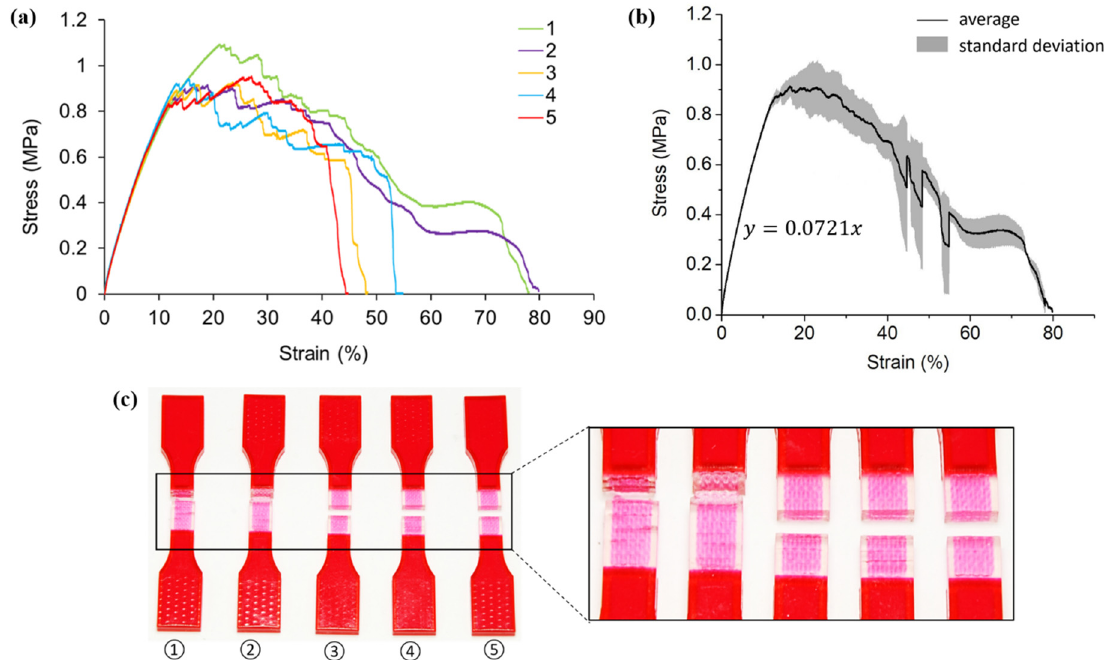
Figure 7. ( a ) Stress-strain curves obtained from tensile testing tests on hybrid case three (pure horizontal second order) samples; ( b ) average tensile stress-strain curve and standard deviation of all five testings; ( c ) pictures of failed tensile samples with zoom-in at the locations of fracture.